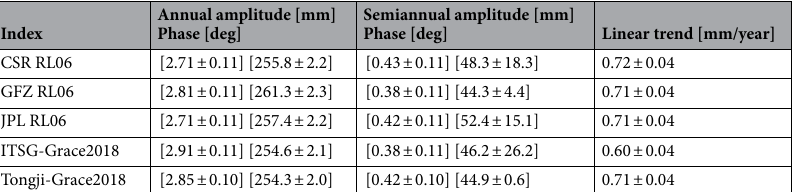
Table 5. Amplitudes and phases of annual and semiannual components and linear trends of GMOM change from degree-1 coefficients from January 2005 to December 2016.